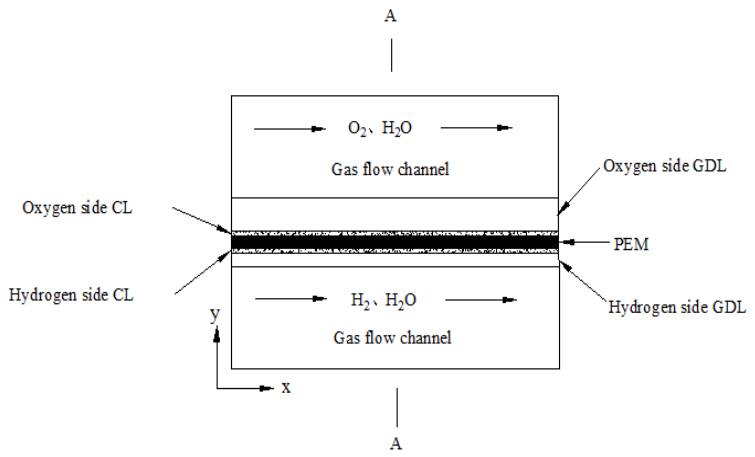
Figure 1. Computational domain of a 2D PEM URFC model.